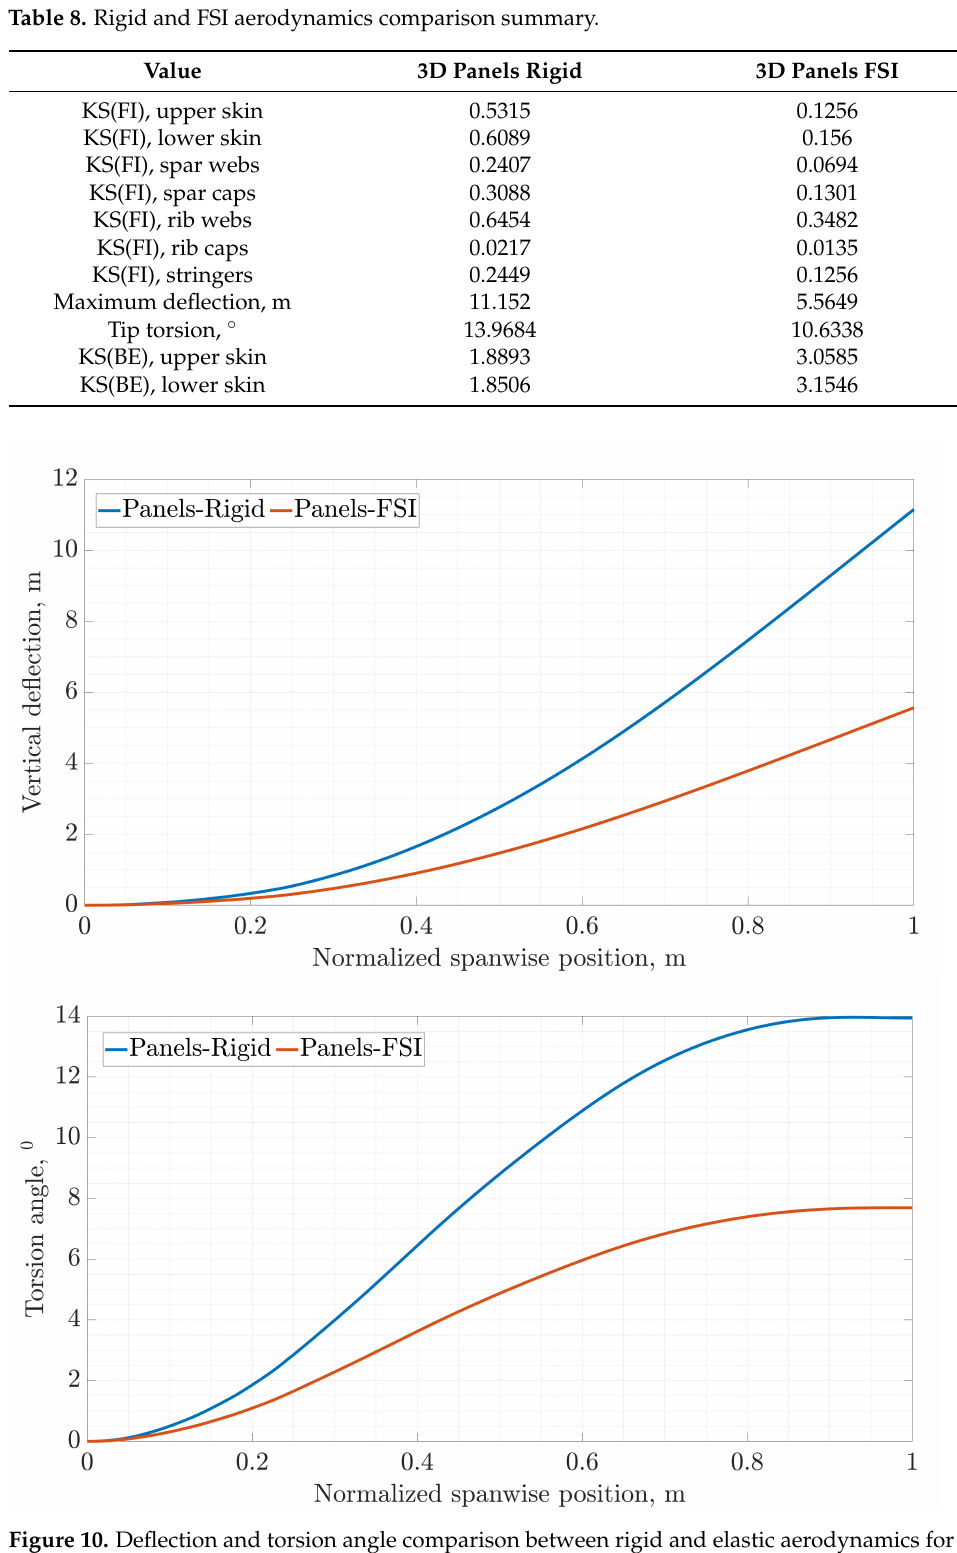
Figure 10. Deflection and torsion angle comparison between rigid and elastic aerodynamics for the uCRM-13.5